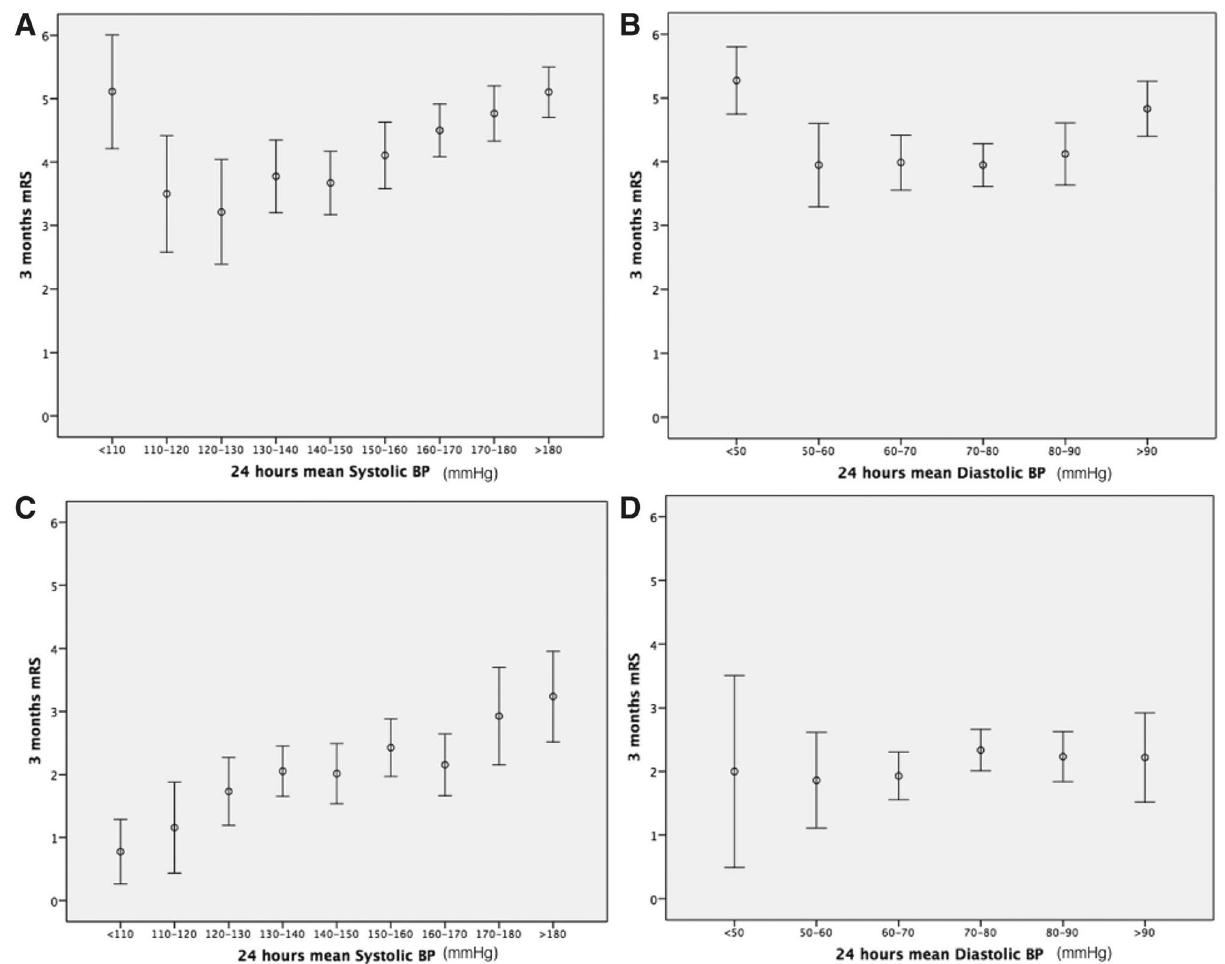
Fig. 2 Relationship between blood pressure (BP) in the first 24 h post ischemic stroke and functional outcome at 3 months (through modified Rankin Scale [mRS]). A and B , Nonrecanalyzed patients. C and D , Recanalyzed patients. Error bars represent the 95% confidence interval for mean. (From Mar- tins AI, Sargento-Freitas J, Silva F, et al. Stroke. 2016;47:1571–1576 with permission from publisher, https://www.ahajournals.org/doi/full/https://doi.